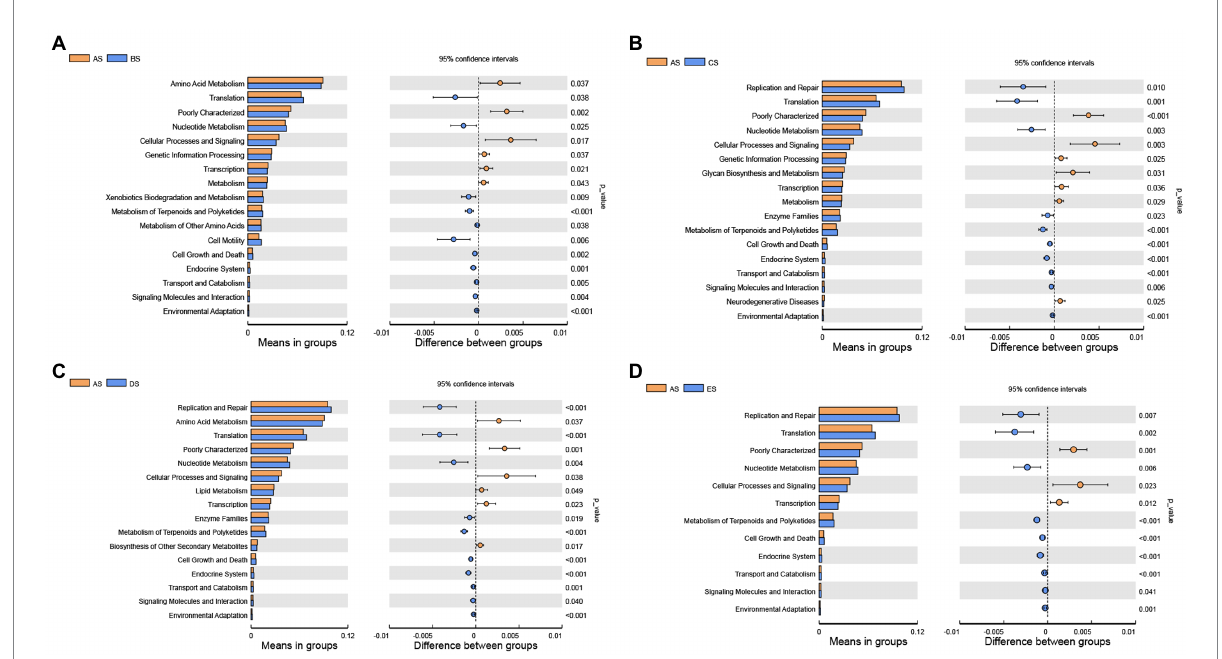
FIGURE 4 Differential analysis of the KEGG second-level functional annotations from the PICRUSt analysis. Differences in bacterial metabolism between the AS and BS groups (A) ; AS and CS groups (B) ; AS and DS groups (C) ; and AS and ES groups (D) . Statistical analyses were performed using a paired Student’s t -test. p < 0.05 indicates significant